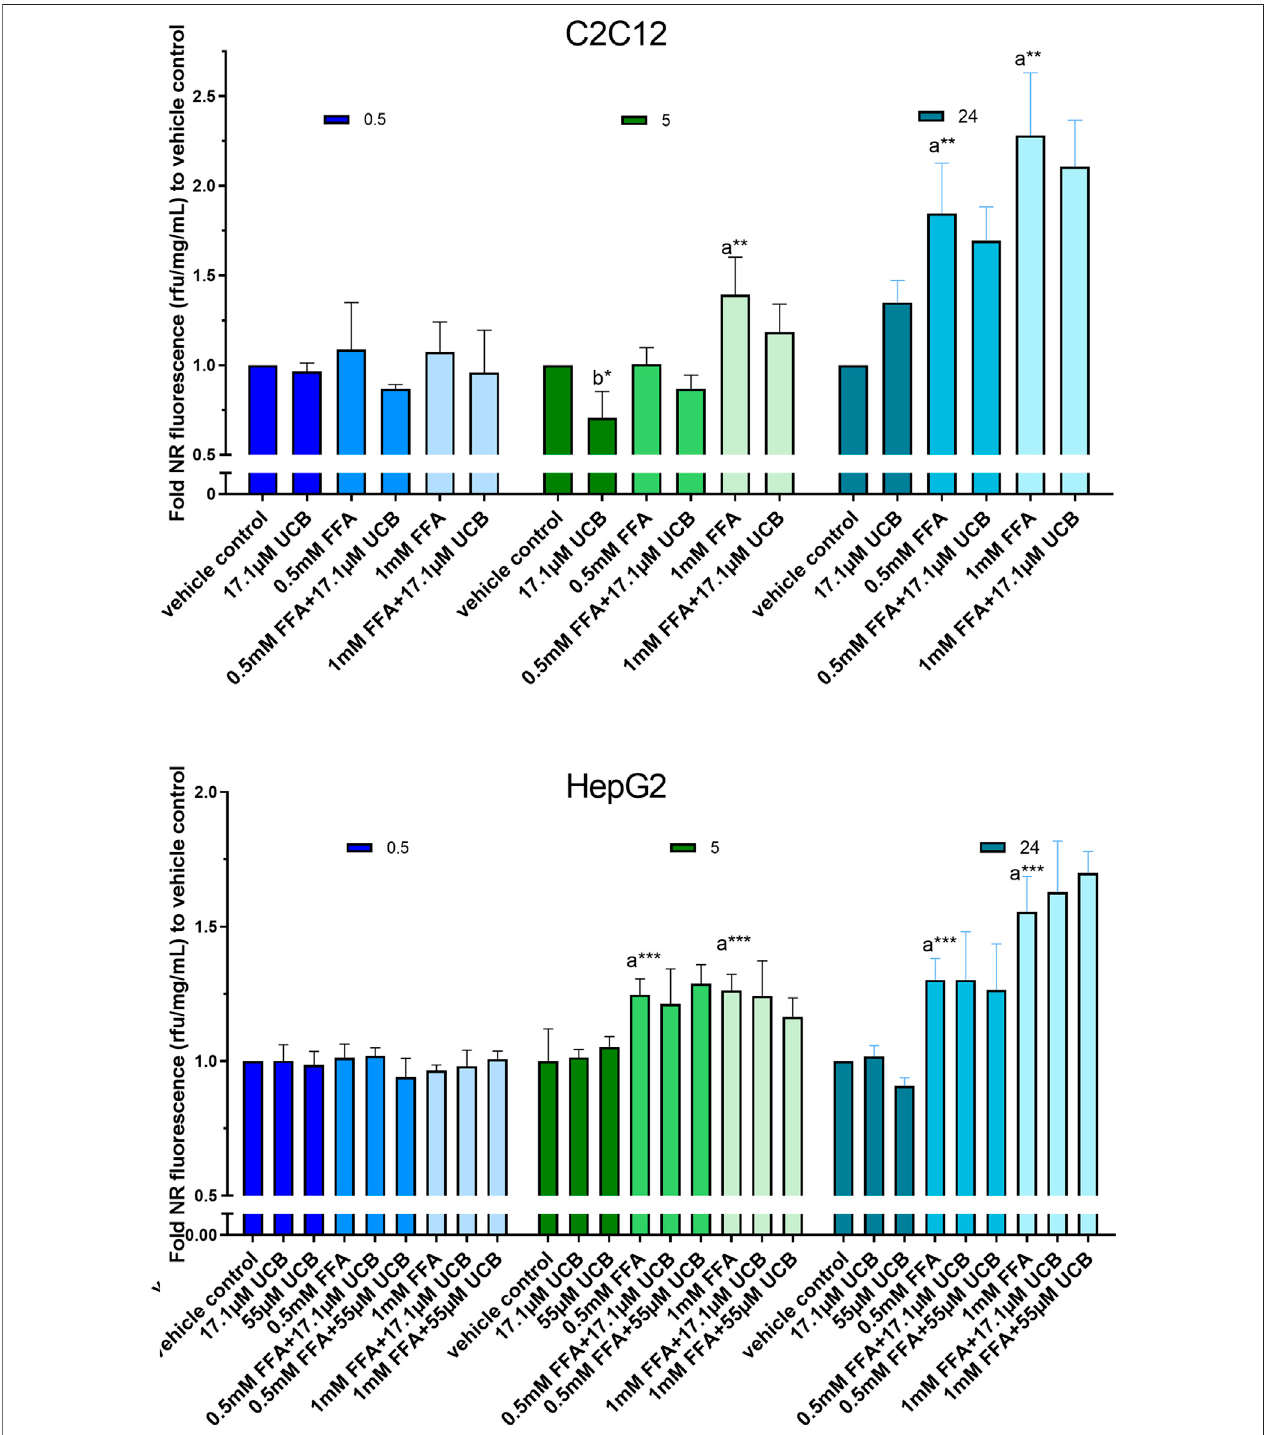
FIGURE 4| UCB had no significant effect on lipid accumulation in C2C12 and HepG2 cells in the presence of glucose. Cells were exposed totreatments for 0.5, 5 and 24 h. NR fl uorescence was adjusted by protein content (rfu/mg/mL) and compared to vehicle control. Data are mean ± SD of n (cid:2) 3 (each in triplicate). Signi fi cant differences according to Bonferroni (*** p ≤ 0.001, ** p ≤ 0.01, * p ≤ 0.05) of a (cid:2) compared to vehicle control and b (cid:2) UCB treated vs. untreated cells.